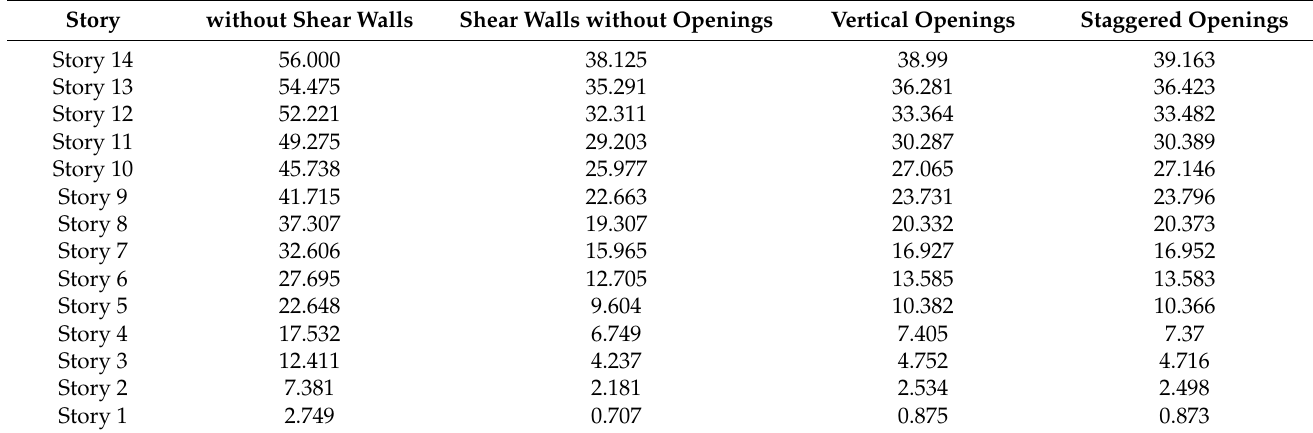
Table 5. Comparison of the story displacements, ESA, and X-direction